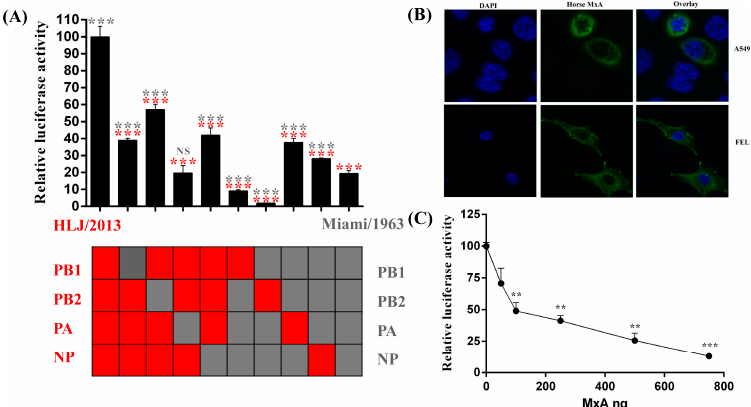
Figure 5. Investigation of EIV polymerase activity ( A ) or the antiviral properties of eqMxA